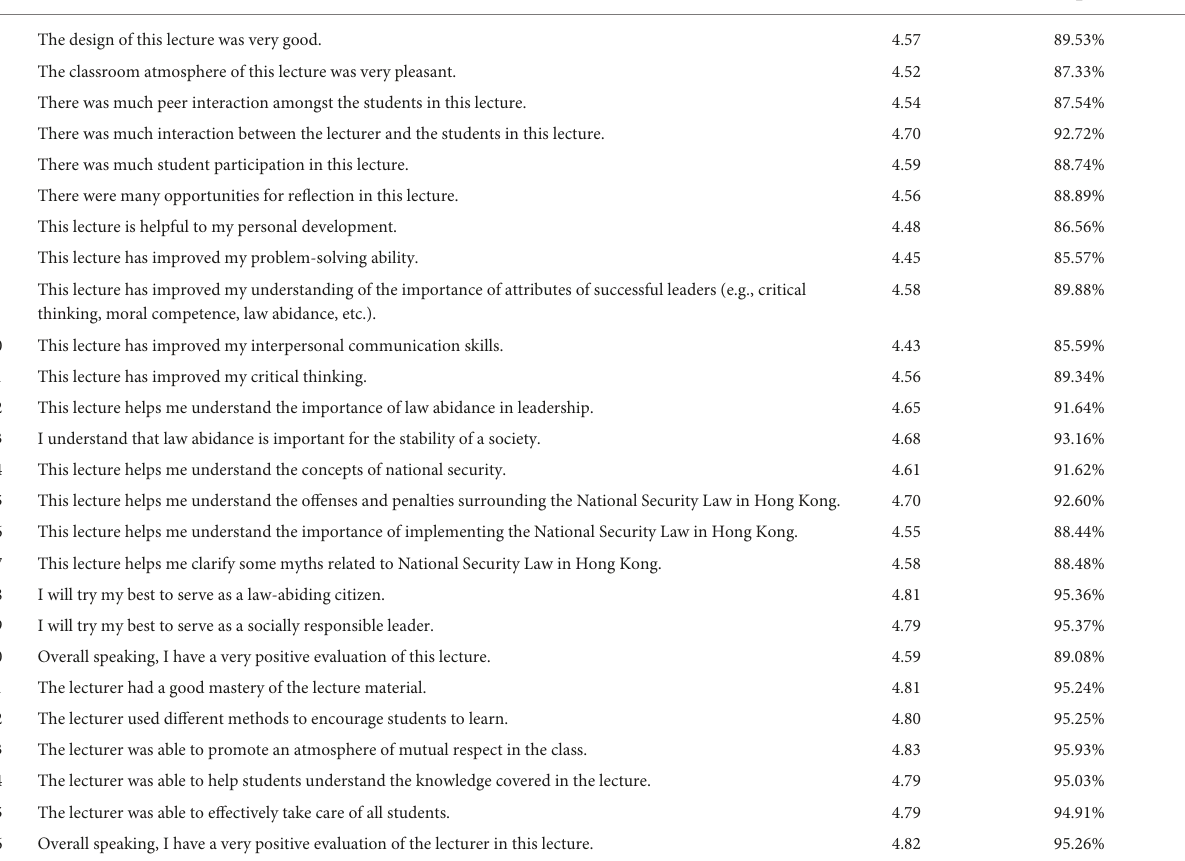
TABLE 4 Responses of the students to the post-lecture evaluation questionnaire ( N = 914). Questionnaire item